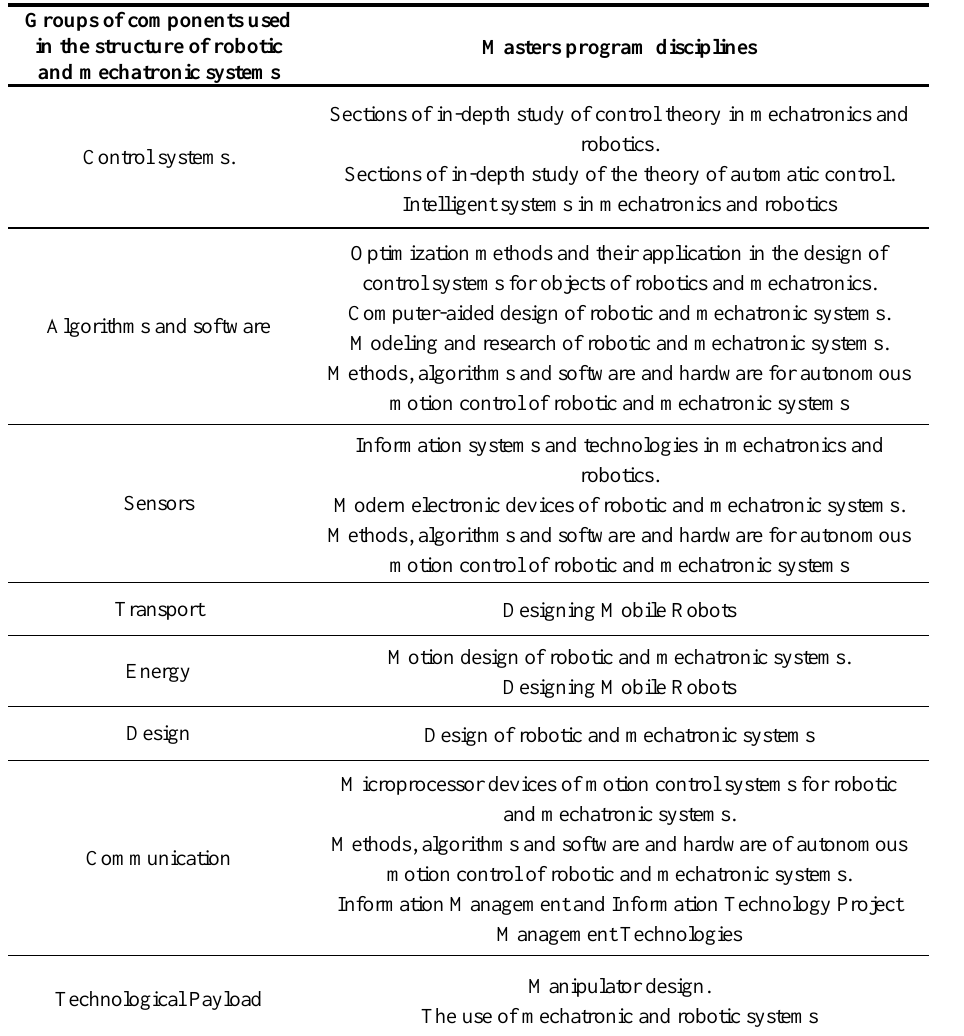
Table 1. Requirements and master training